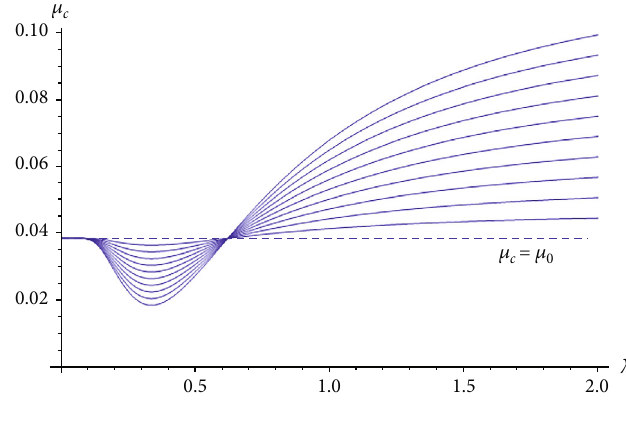
λ for α < 0 . c versus